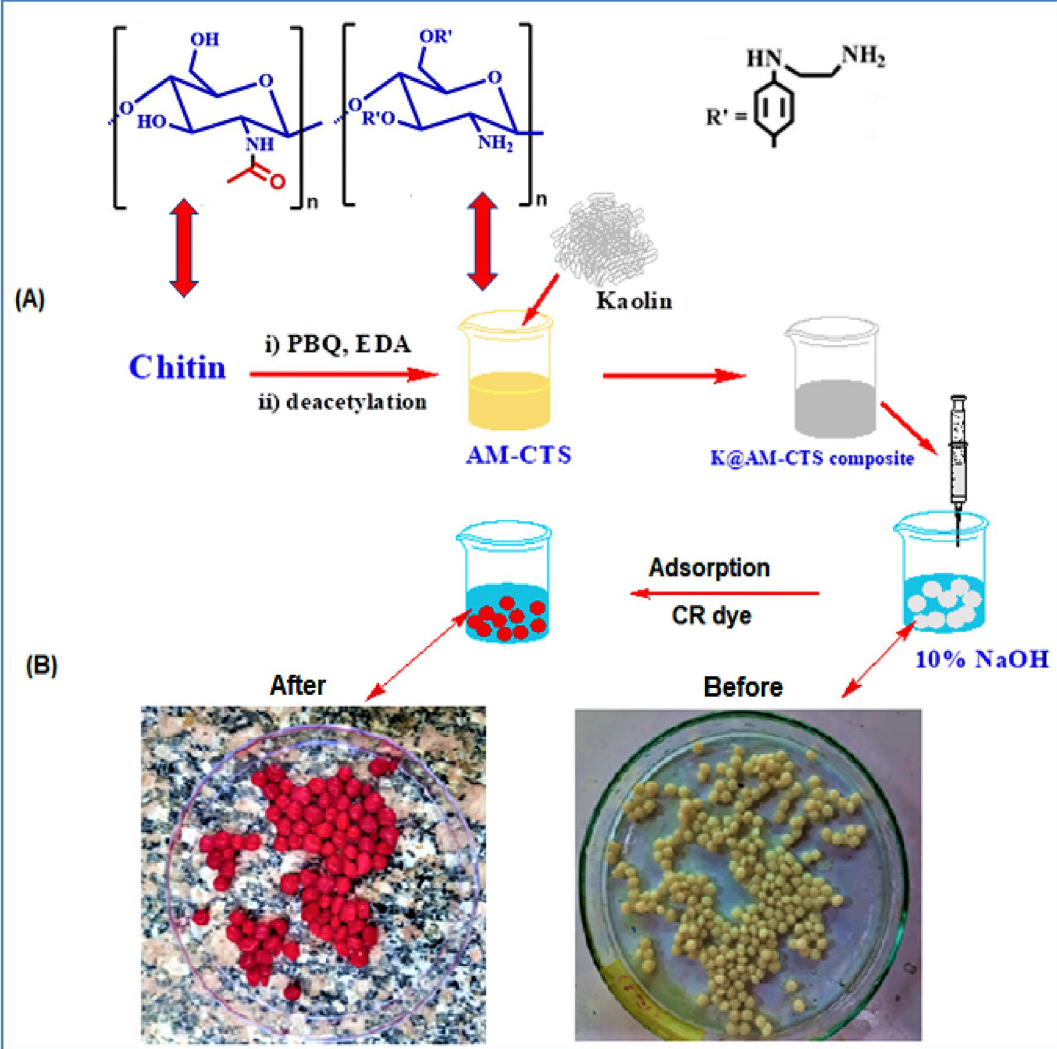
Figure 1. ( A ) A schematic representation for the formulation of K@AM-CTS composite beads and ( B ) digital laboratory images of freshly prepared beads before and after adsorption of Congo red